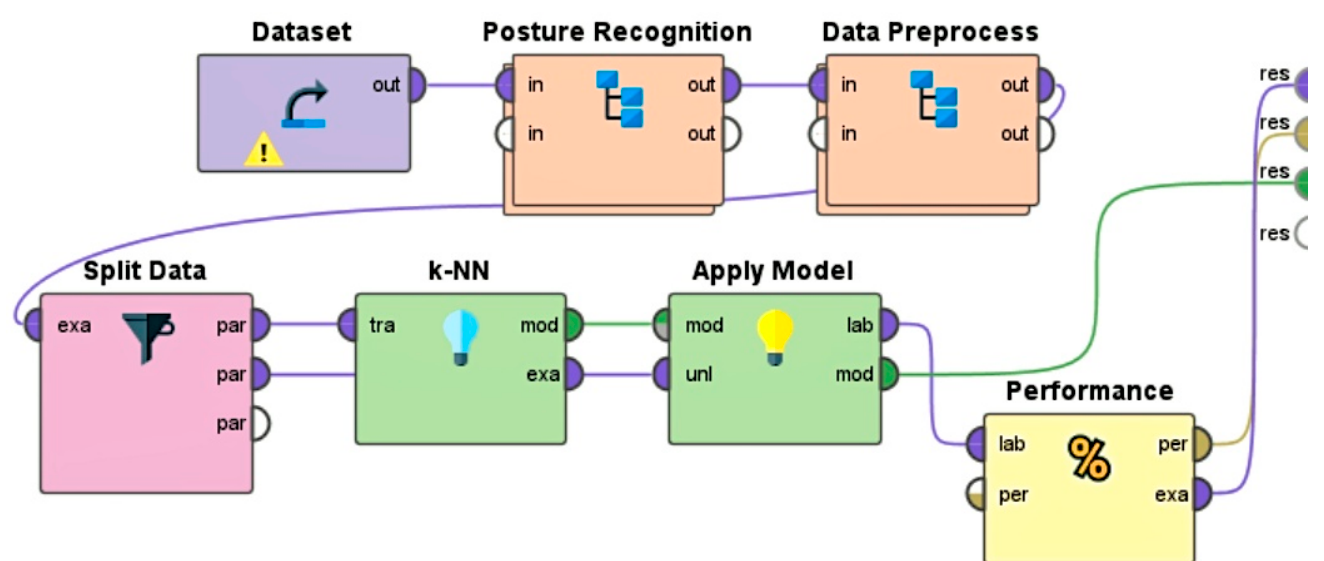
Figure 2. The process that was developed in RapidMiner as per the system architecture of the machine learning-based approach for detecting falls and fall-related motions.